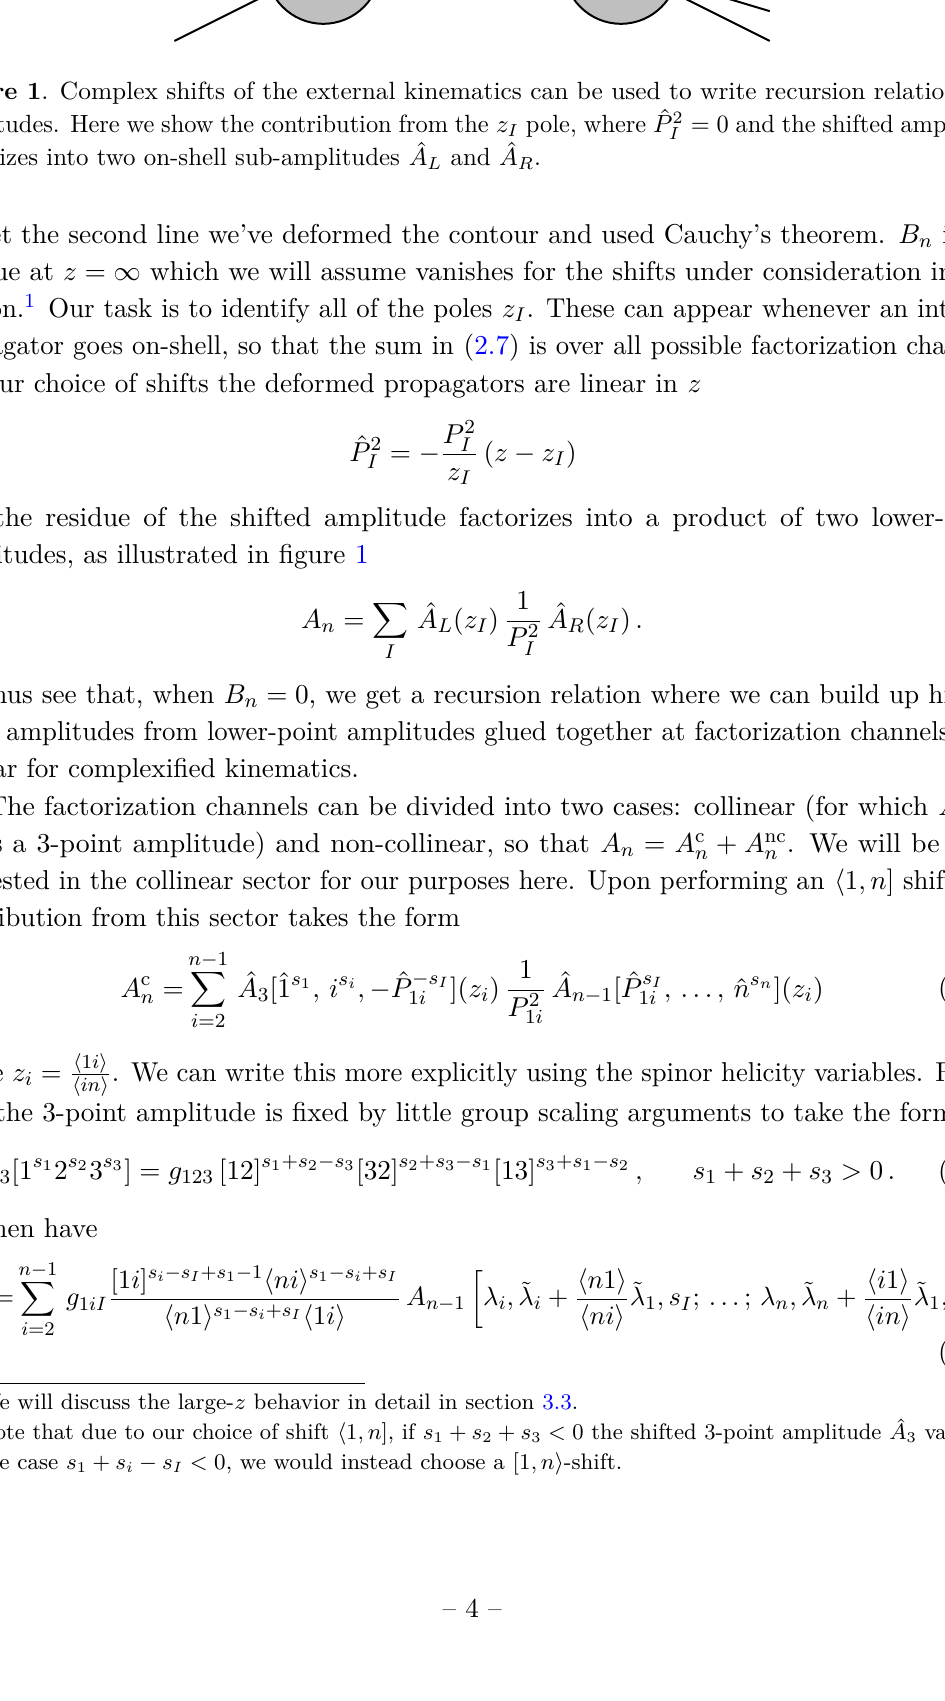
pole, where ˆ P 2 = 0 and the shifted amplitude I I and ˆ A L R